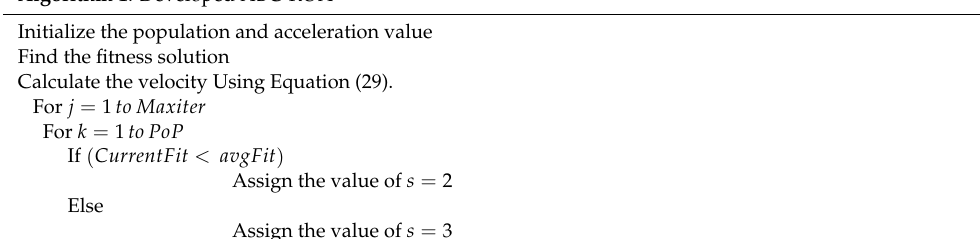
Algorithm 1 : Developed